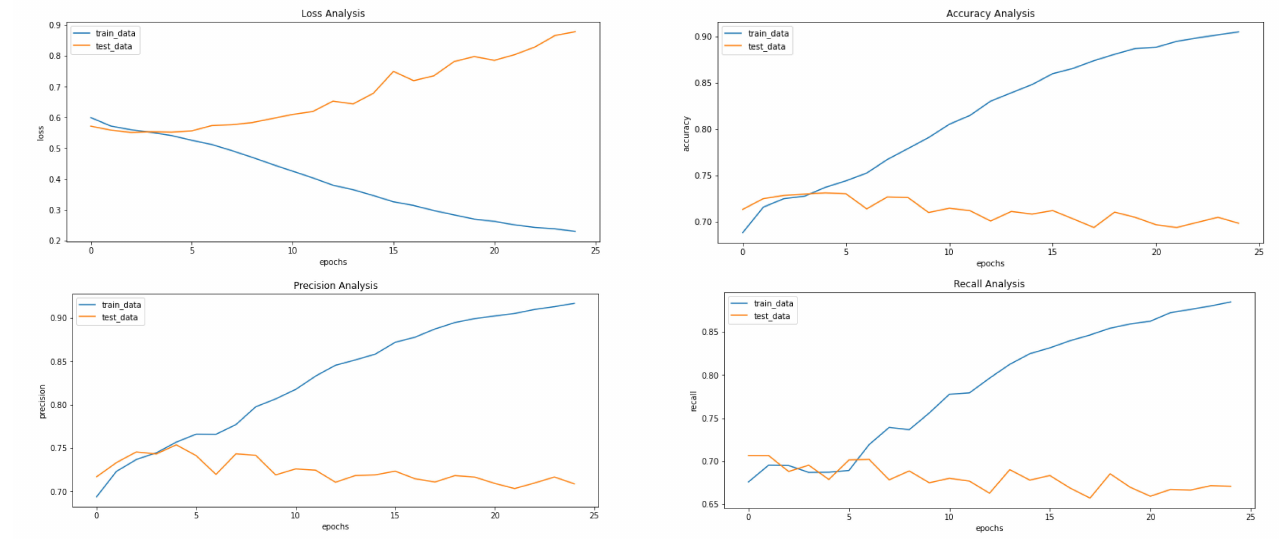
Figure 5. Results achieved after classification using CNN before applying VAE. It shows loss, accuracy, precision and recall from left to